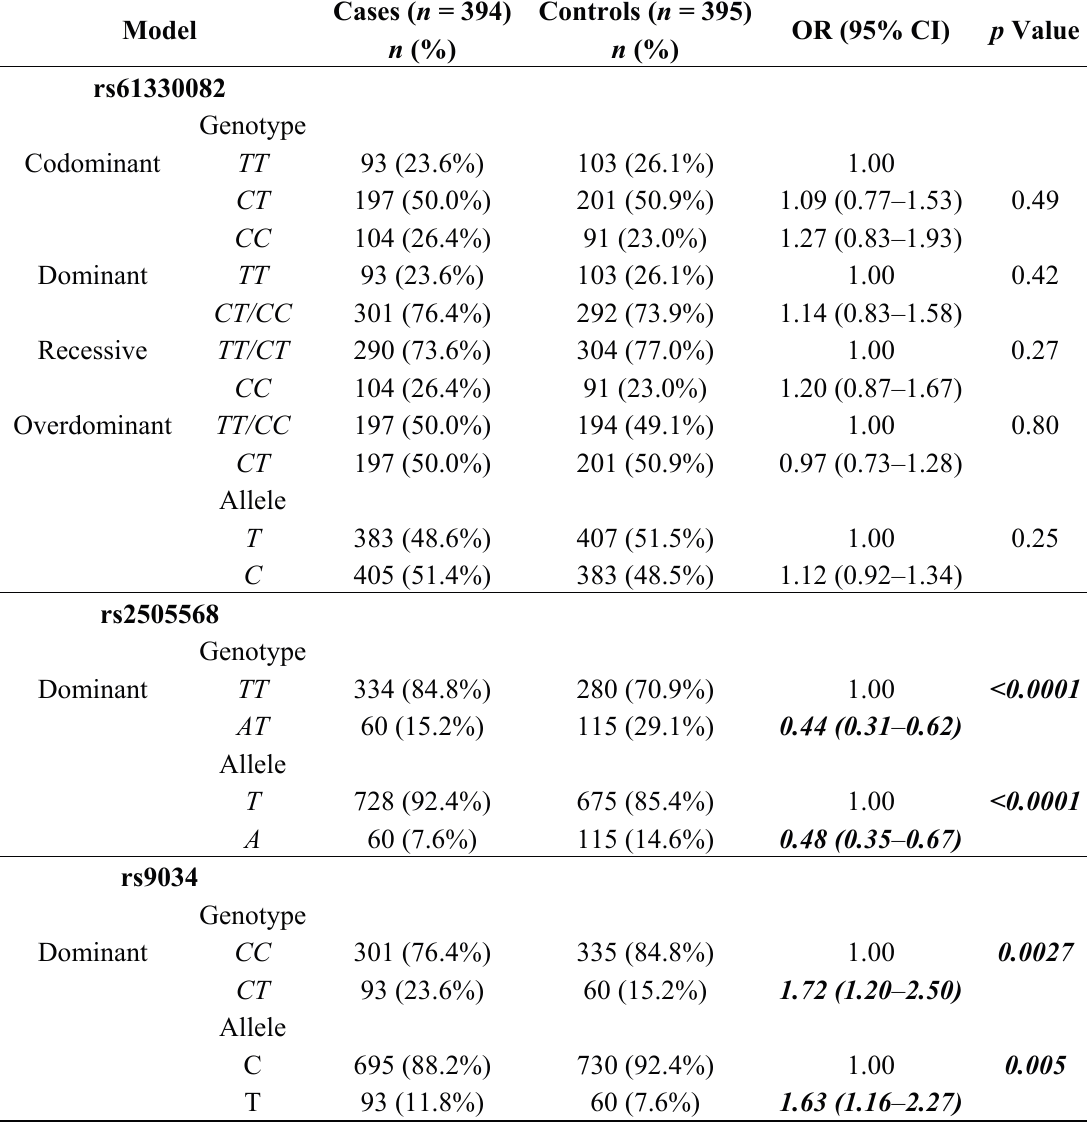
Table 2. Distribution of SNP in NAMPT among cases and controls and their association with DCM